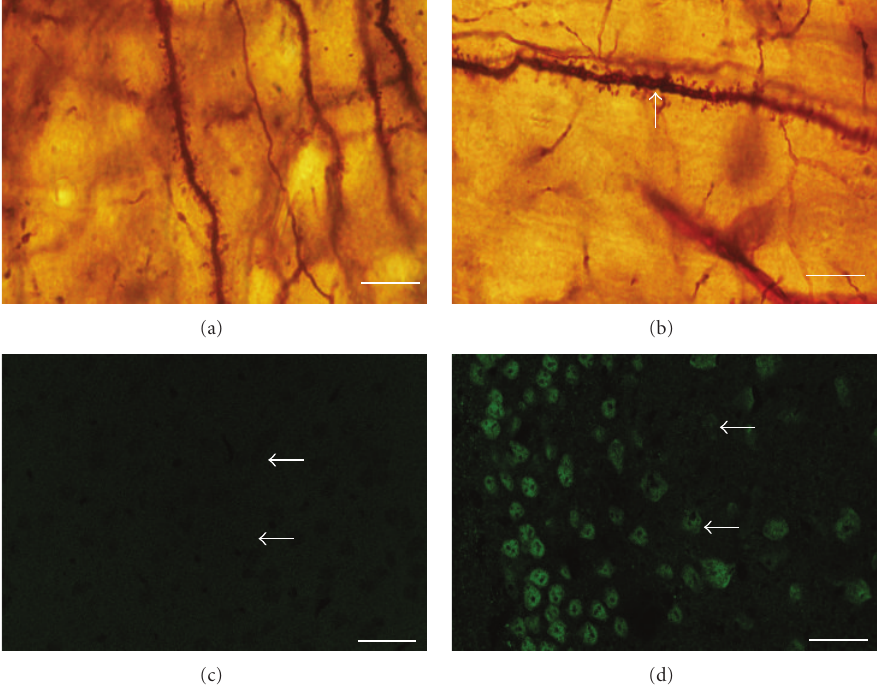
Figure 12: Photomicrograph of cortex pyramidal cells with Golgi stain. (a) Dendrite with spine dendrite in a control. (b) Exposure to vanadium, area with spine dendritic loss (arrow). (c) Image from a section of the cerebral cortex in control mice (confocal): the neuronal bodies (arrows). (d) Pyramidal cell neurons exposed to vanadium stained with 4-HNE (arrows). Scale bars: (a), (b) 10 μ m; (c), (d) 50 μ